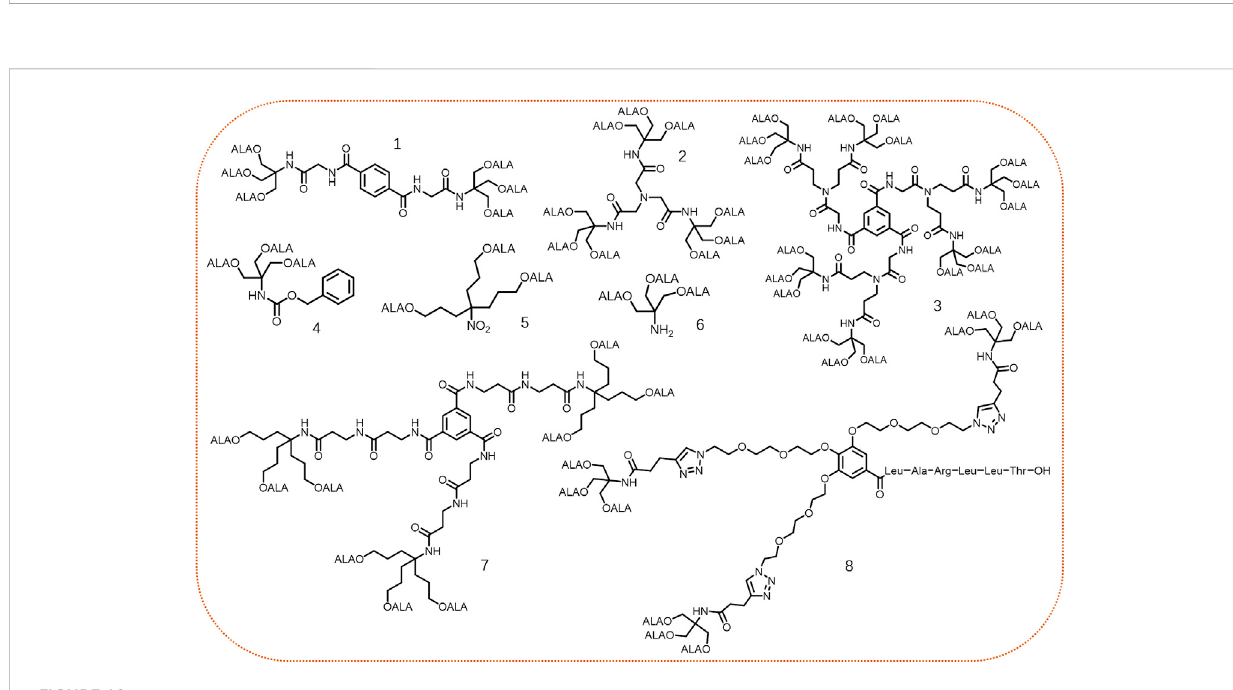
FIGURE 10 Representative structures of ALA-based